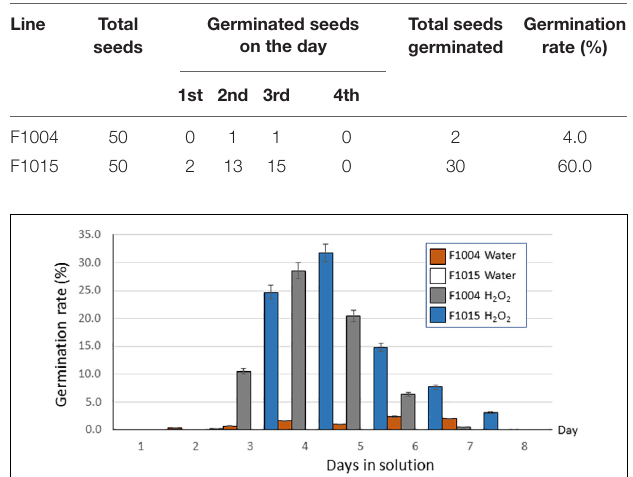
TABLE 4 | Germination of seeds isolated from the seedballs of F1004 and F1015 in distilled water at room temperature under natural light.